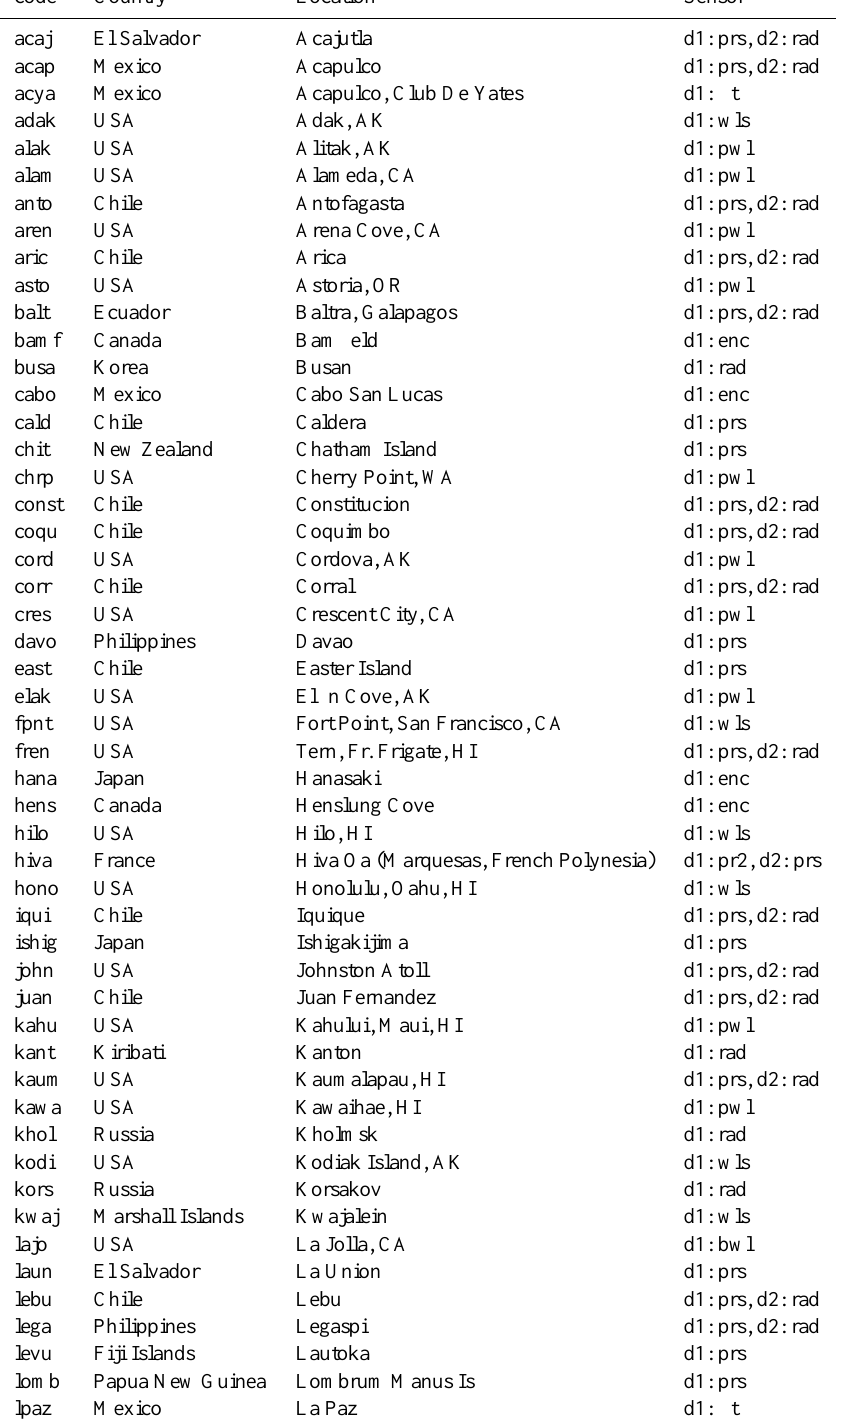
Table 1. List of the stations selected for the analysis. The station code (first column) is the same used on the IOC website. The type of instrument (last column) is coded as follows in the IOC database: bwl= backup water level gauge, enc=encoder sensor, flt=float gauge, prs= pressure gauge, pwl=primary water level gauge, rad=radar gauge, wls= water level sensor. In stations with a double water level sensor, often one is assumed as the pwl and the other as the bwl. Only stations with 1-min sample rate recordings have been selected from the IOC